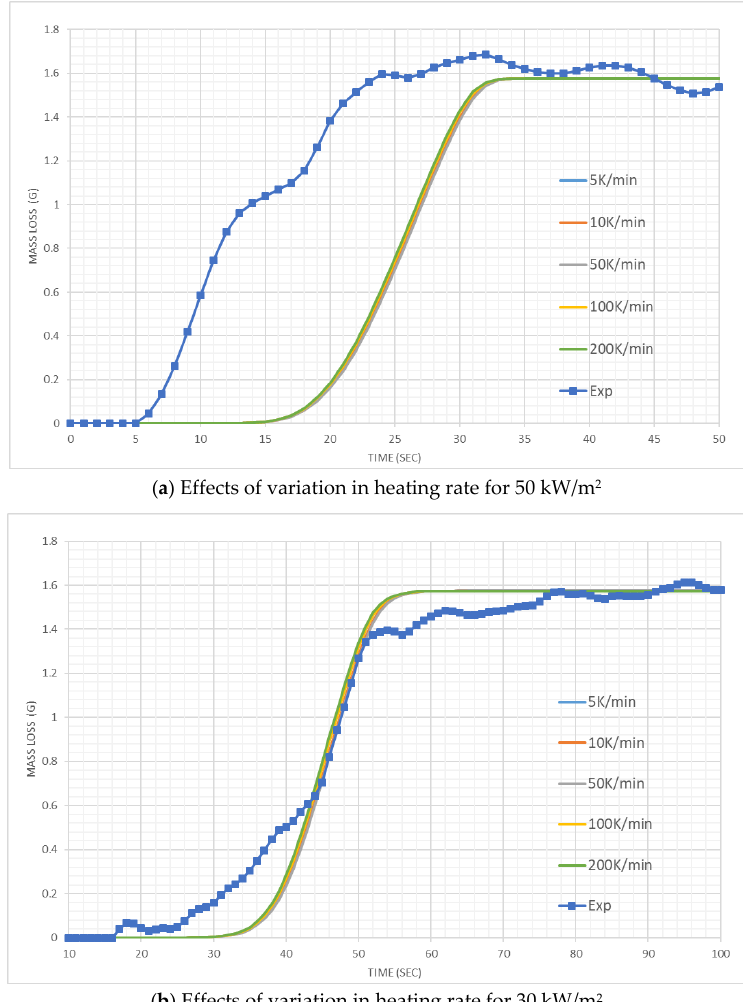
Figure 9. Mass loss results for the cone calorimeter tests with Cotton.